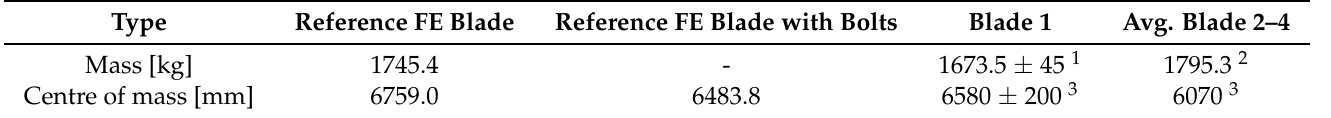
Table 7. Mass distribution and centre of mass.